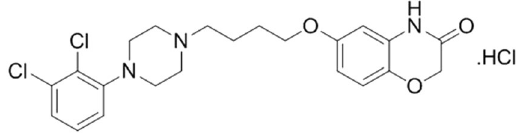
Figure 1. The structure of PCC0104005.